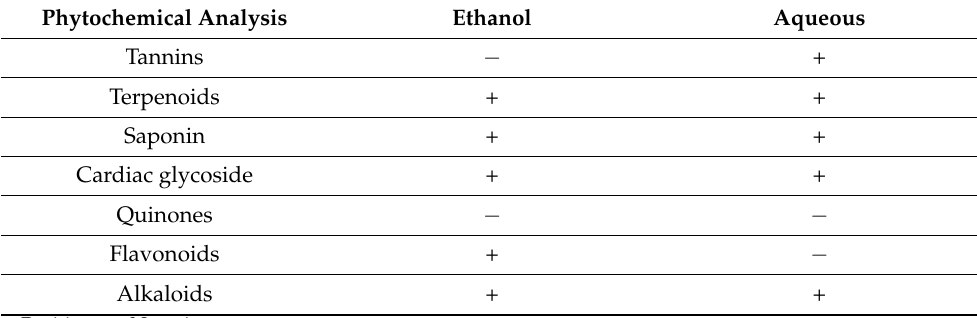
Table 1. Phytochemical analysis of the extracts of bitter ginger ( Z. zerumbet ). Phytochemical Analysis Ethanol Aqueous Tannins − + Terpenoids + + Saponin + + Cardiac glycoside + + Quinones − − Flavonoids + − Alkaloids + +